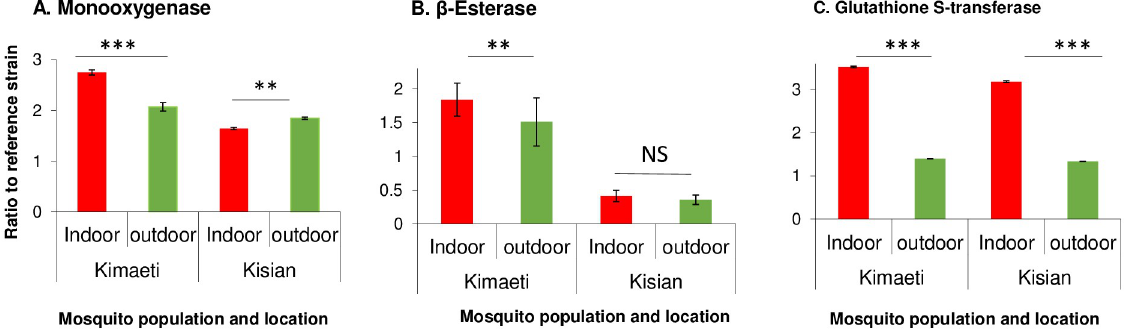
Fig 3. Metabolic enzyme activity for indoor and outdoor resting F1 progeny of An . gambiae from Kisian and Kimaeti in Western Kenya. A: monooxygenases; B: β -esterases; and C: Glutathione S-transferase. Enzyme activities were expressed as the ratio of a population of interest to the Kisumu reference strain. Error bars indicates 95% confidence intervals. � , P < 0.05; ��� , P < 0.001; NS; not significant.